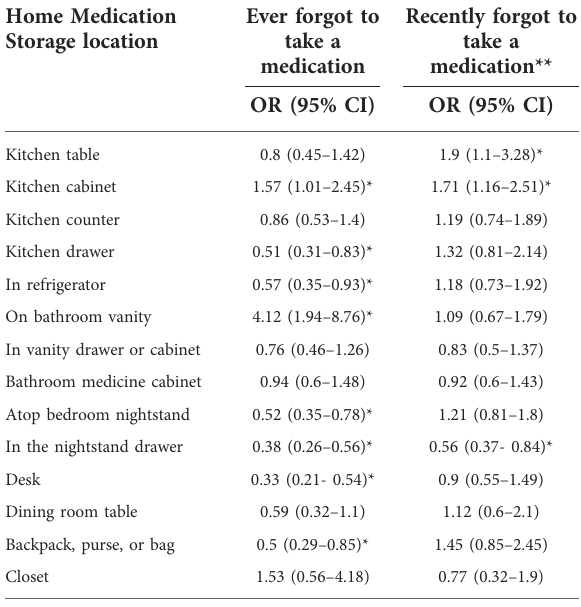
TABLE 3 Bivariate associations between home medication storage location and self-reported medication adherence. Home Medication Storage